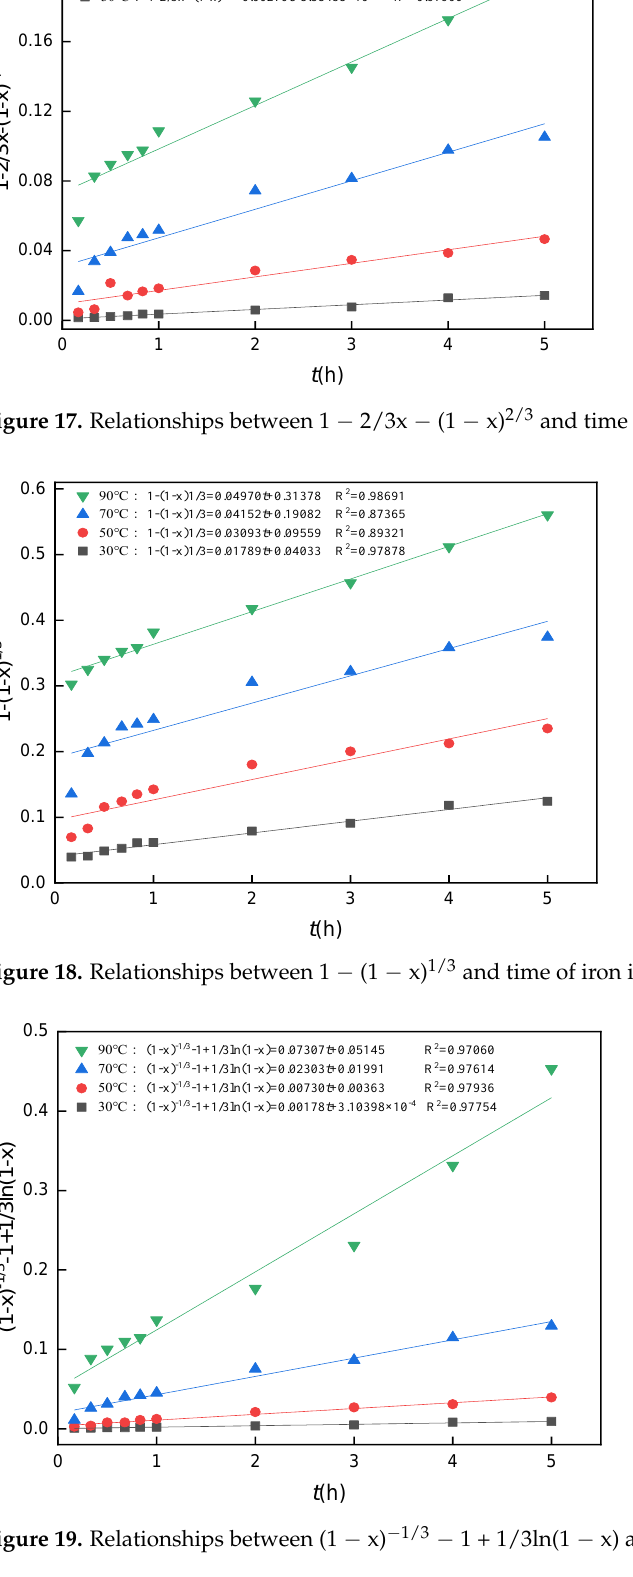
Figure 19. Relationships between (1 − x ) − 1/3 − 1 + 1/3ln(1 − x ) and time of iron ions.